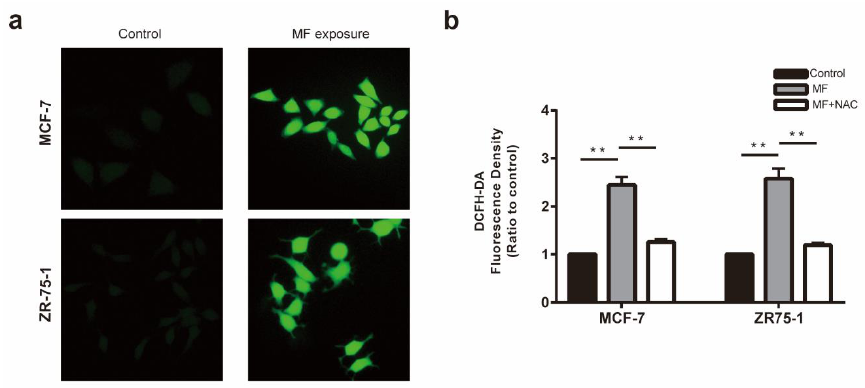
Figure 4. MF enhanced the ROS levels and inhibited the activities of the PI3K / AKT signaling pathways in MCF-7 and ZR-75-1 cells. ( a ) The representative images under a fluorescence microscope (40 × ) showed that excessive ROS was produced after 2 h of exposure to MF. ( b ) Statistics analysis of the fluorescence intensity in the cells stained with DCFH-DA, which was read from the multi-mode microplate reader, showed the ROS level increased significantly in MCF-7 and ZR-75-1 cells exposed to MF. Data are presented as the mean ± standard deviation (SD); n = 3; ** p < 0.01.